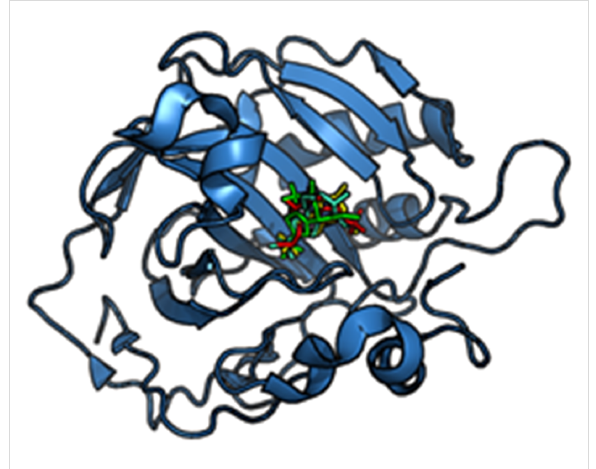
Figure 5: Binding mode prediction. The known inhibitor Dorzolamide is docked into Carbonic anhydrase II crystal structure (4M2U) (blue) using AutoDock Vina. Four binding poses predicted are shown in green, cyan, red and yellow. The molecular structure of Dorzolamide is shown in Figure